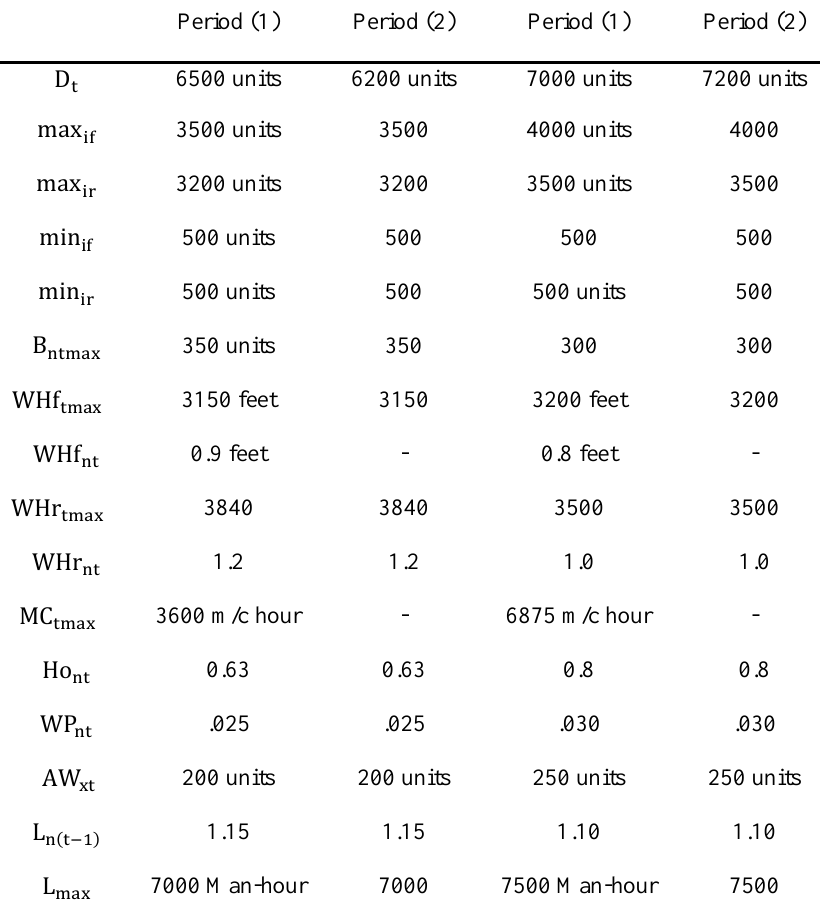
Table 4. Other relevant data for calculation.